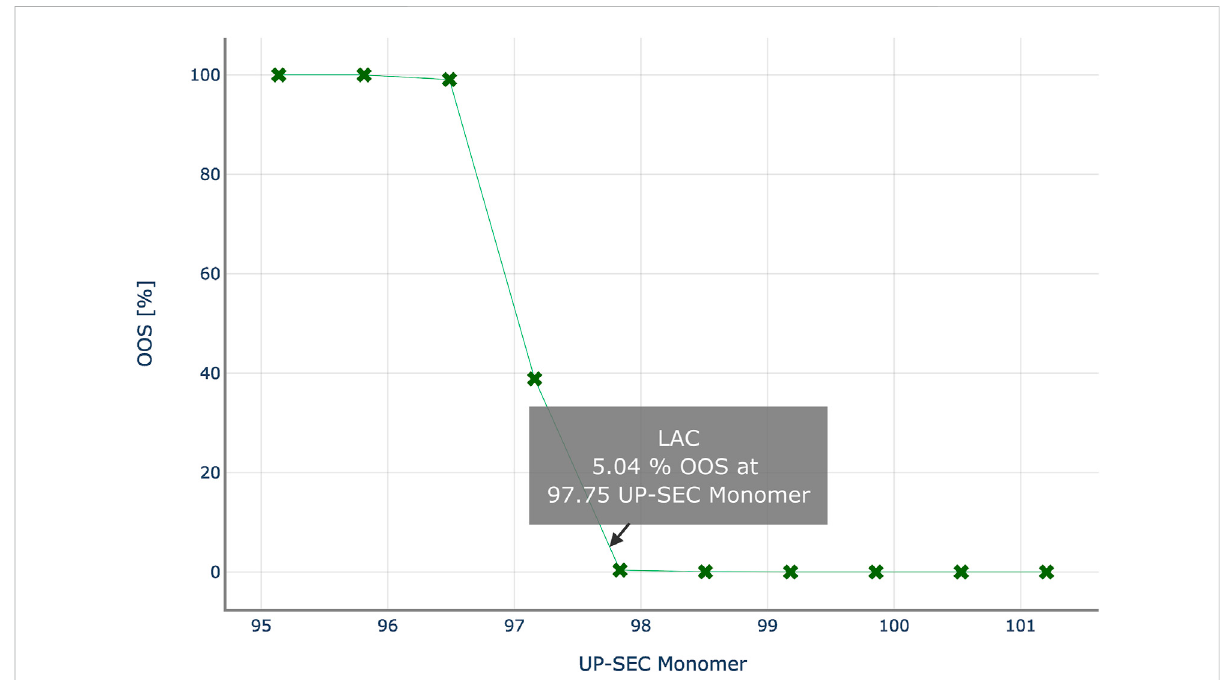
FIGURE 8 Out-of-speci fi cation probability at drug substance for various theoretical UP-SEC Monomer pool values in unit operation 2. Intermediate acceptance criteria are de fi ned, as the CQA ’ s pool value, for which the out-of-speci fi cation probability equals a critical threshold, here